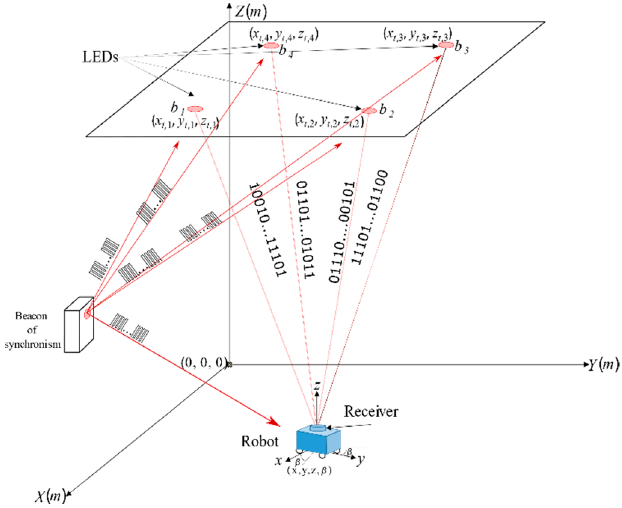
Figure 1. General diagram of the proposed positioning system.